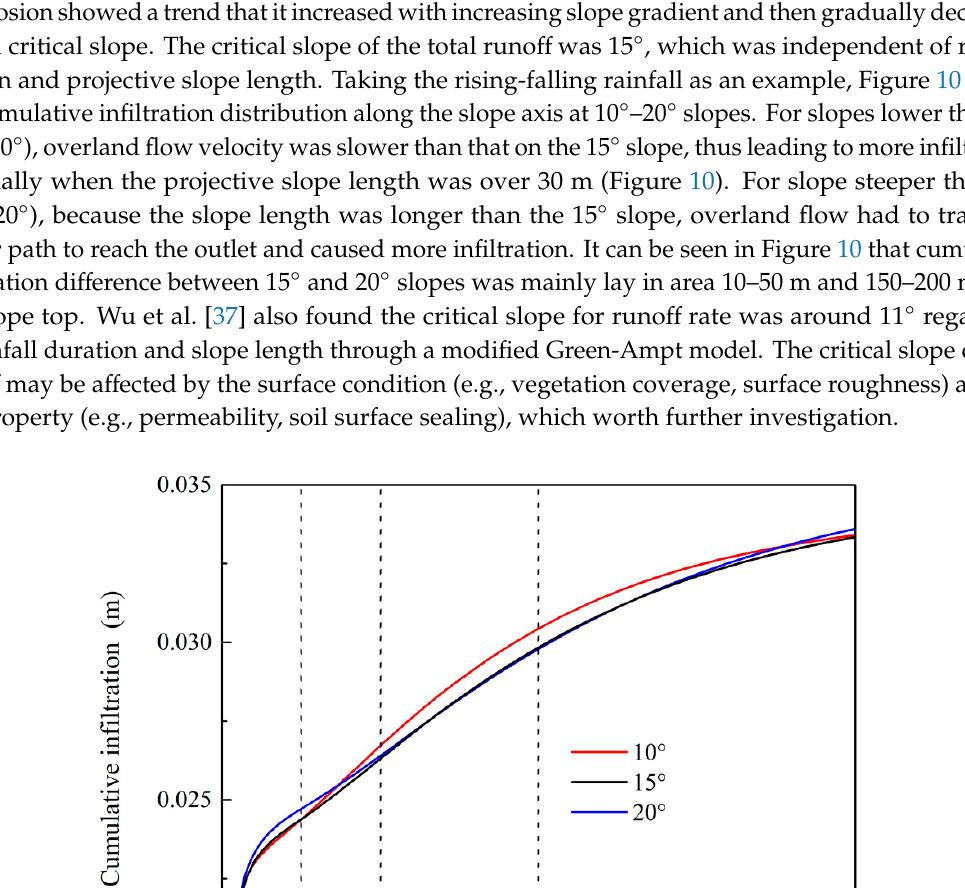
Figure 11. The erosion depth distribution along the slope axis under rising-falling rainfall at 25°–35° slopes. 4.3. Effect of Rainfall Patterns on Runoff and Soil Erosion Peaks The time and value of the peak discharge as well as peak erosion rate were greatly influenced by the rainfall pattern. For the non-constant rainfall patterns, the increasing rainfall had the highest peak discharges and peak erosion rates, which was also mentioned in previous studies (e.g., [33]). Under increasing rainfall, as the rainfall intensity gradually increased and the surface gradually